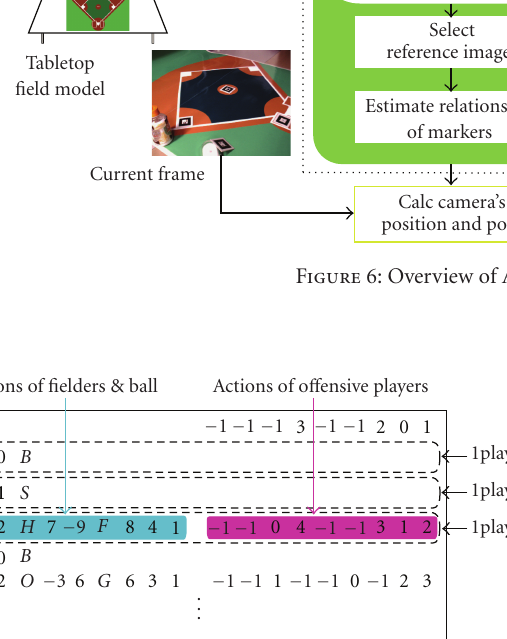
Figure 7: Scorebook Data File